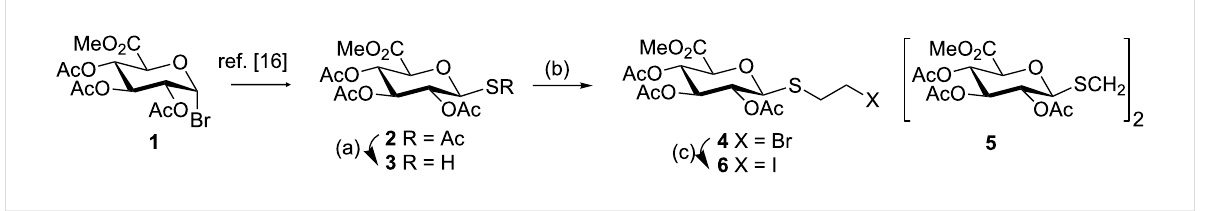
Scheme 1: Synthesis of methyl 2-haloethyl 1-thio-glucuronide derivatives: (a) 1 M NaOMe, MeOH, − 60 °C to − 45 °C, 89% ; (b) Br(CH 2 ) 2 Br, NaH, DMF, − 5 °C (80% for 4 , 3% for 5 ); (c) NaI, acetone, 4 °C, 16 h,